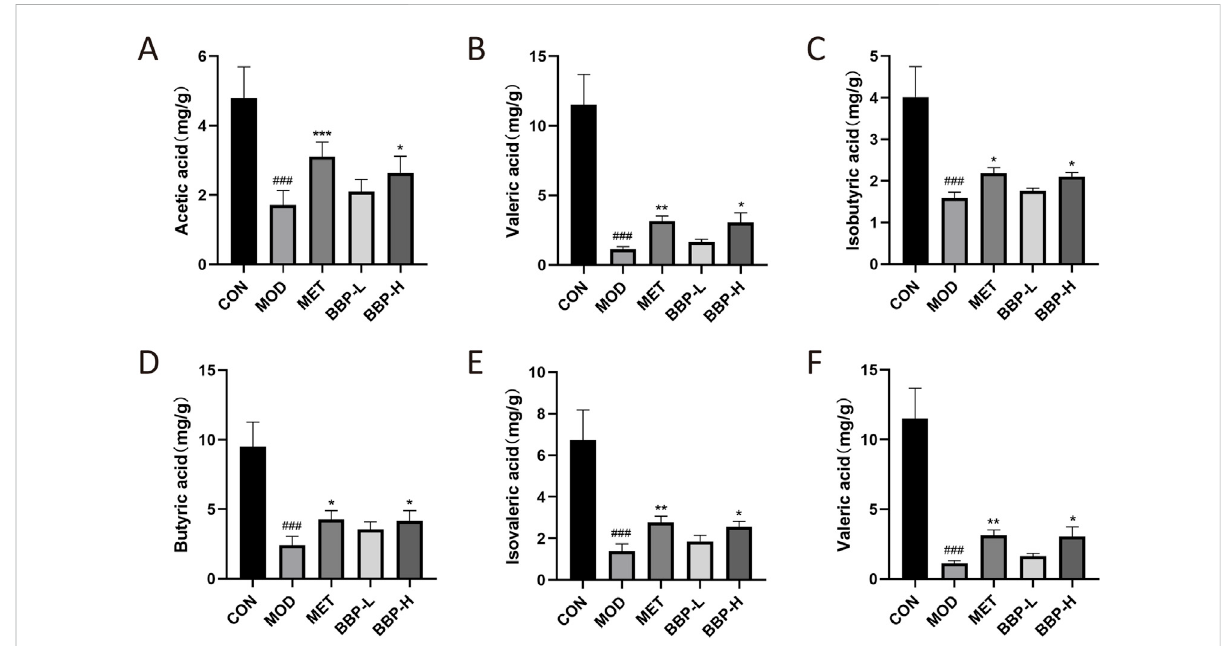
FIGURE 10 ContentsofSCFAsincecumcontentsofratsineachgroup.Aceticacid (A) ,Propionicacid (B) ,Isobutyricacid (C) ,Butyricacid (D) ,Isovalericacid (E) , Valeric acid (F) . Values are presented as the mean ± SD, n = 6. # p < .05, ## p < .01, ### p < .001: model vs. control; * p < .05, ** p < .01, *** p < .001: treatment vs.